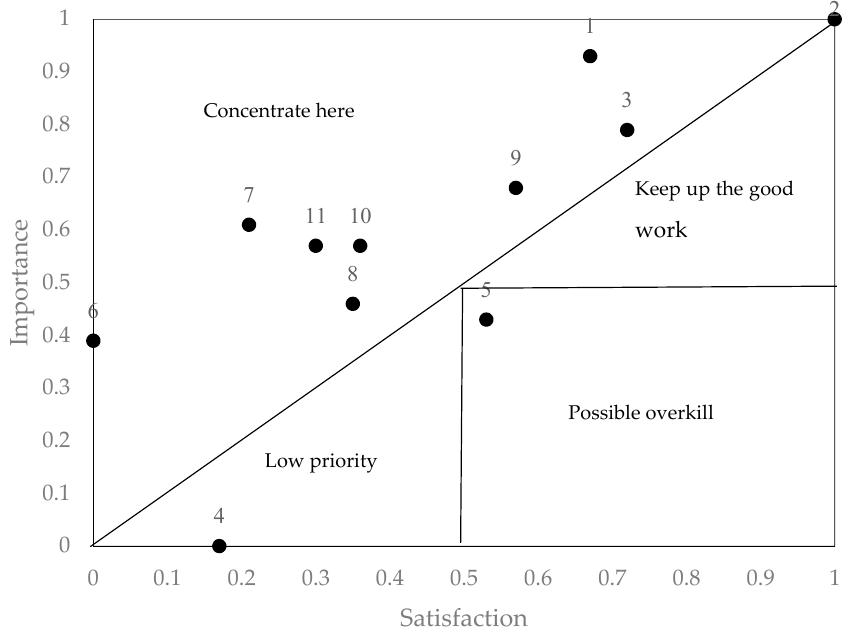
Figure 2. Representation of combined classic and diagonal models.